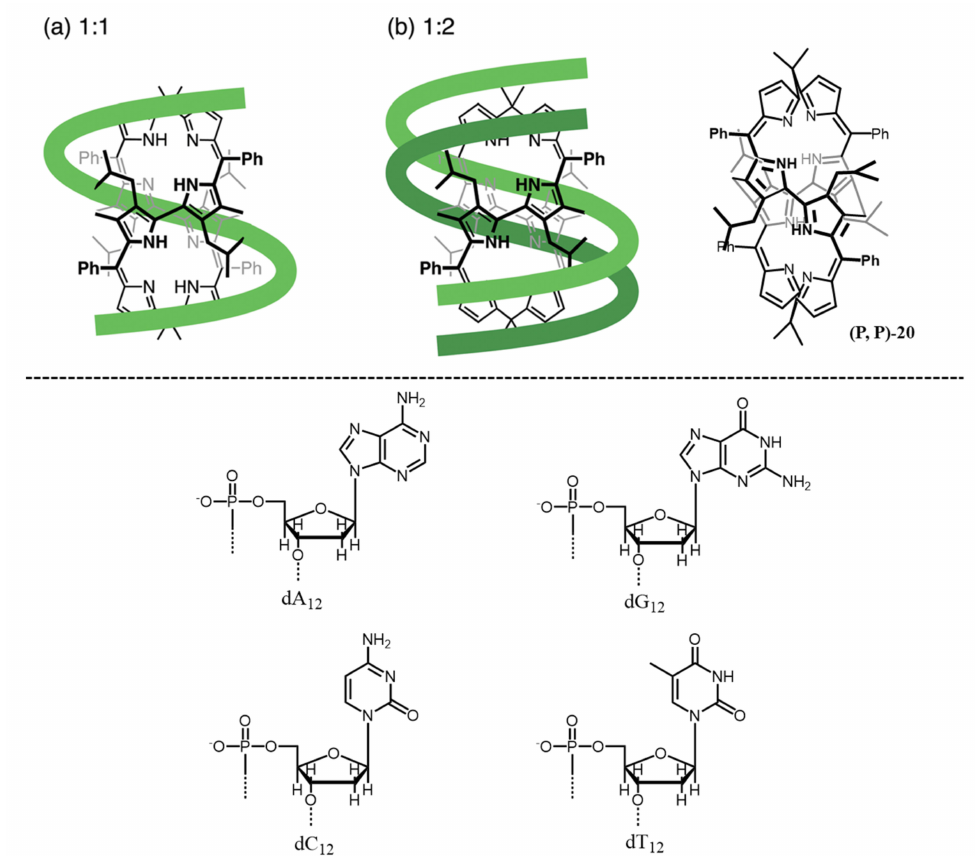
Figure 7. Possible associations of 20 turning to ( M , M )- conformation and dT12 in ( a ) 1: 1 and ( b ) 1: 2 complexations. Reprinted (adapted) with permission from Ref. [33] Copyright 2020 from The Royal Society of Chemistry. Additionally, the chemical structure of ( P , P )- conformation of 20 . Chemical structure of nucleotides and